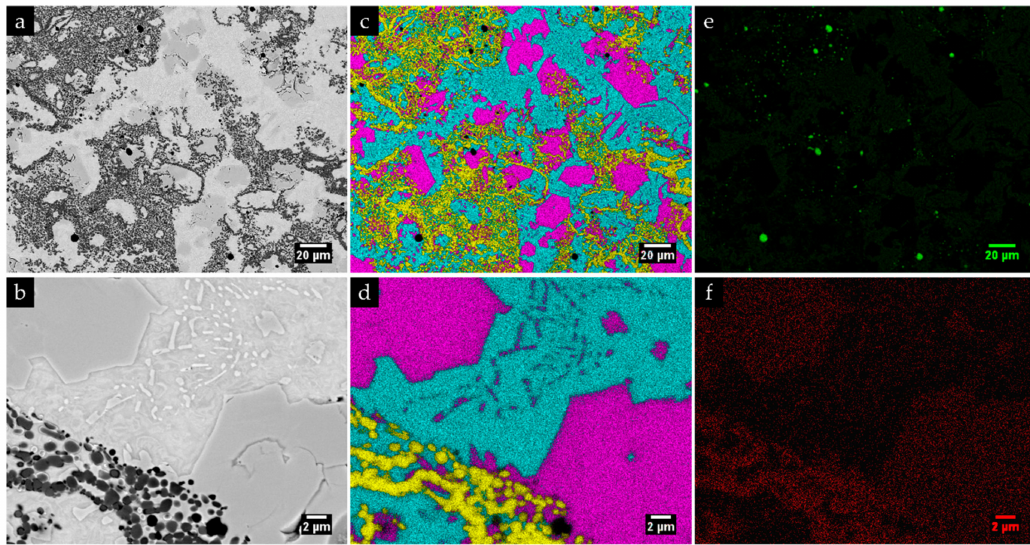
Figure 12. SEM-BSE images of the microstructure of the composite zone ( a , b ) at higher magnification; energy-dispersive spectroscopy (EDS) elemental mapping: ( c , d ) superposition of Cr (pink), Ti (yellow), and Fe (blue); ( e ) mapping of Al and ( f ) mapping of